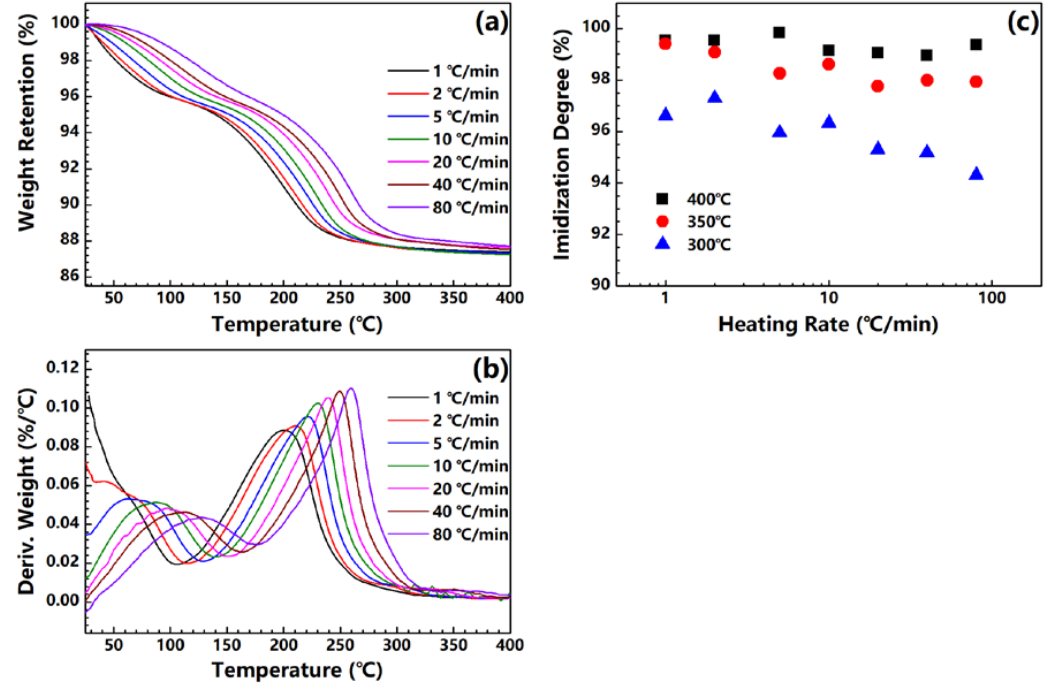
Figure 2. ( a ) TGA and ( b ) DTG curves of PAA fibers under different heating rates; ( c ) imidization degree of PI fibers obtained at 300 °C, 350 °C and 400 °C under different heating rates.